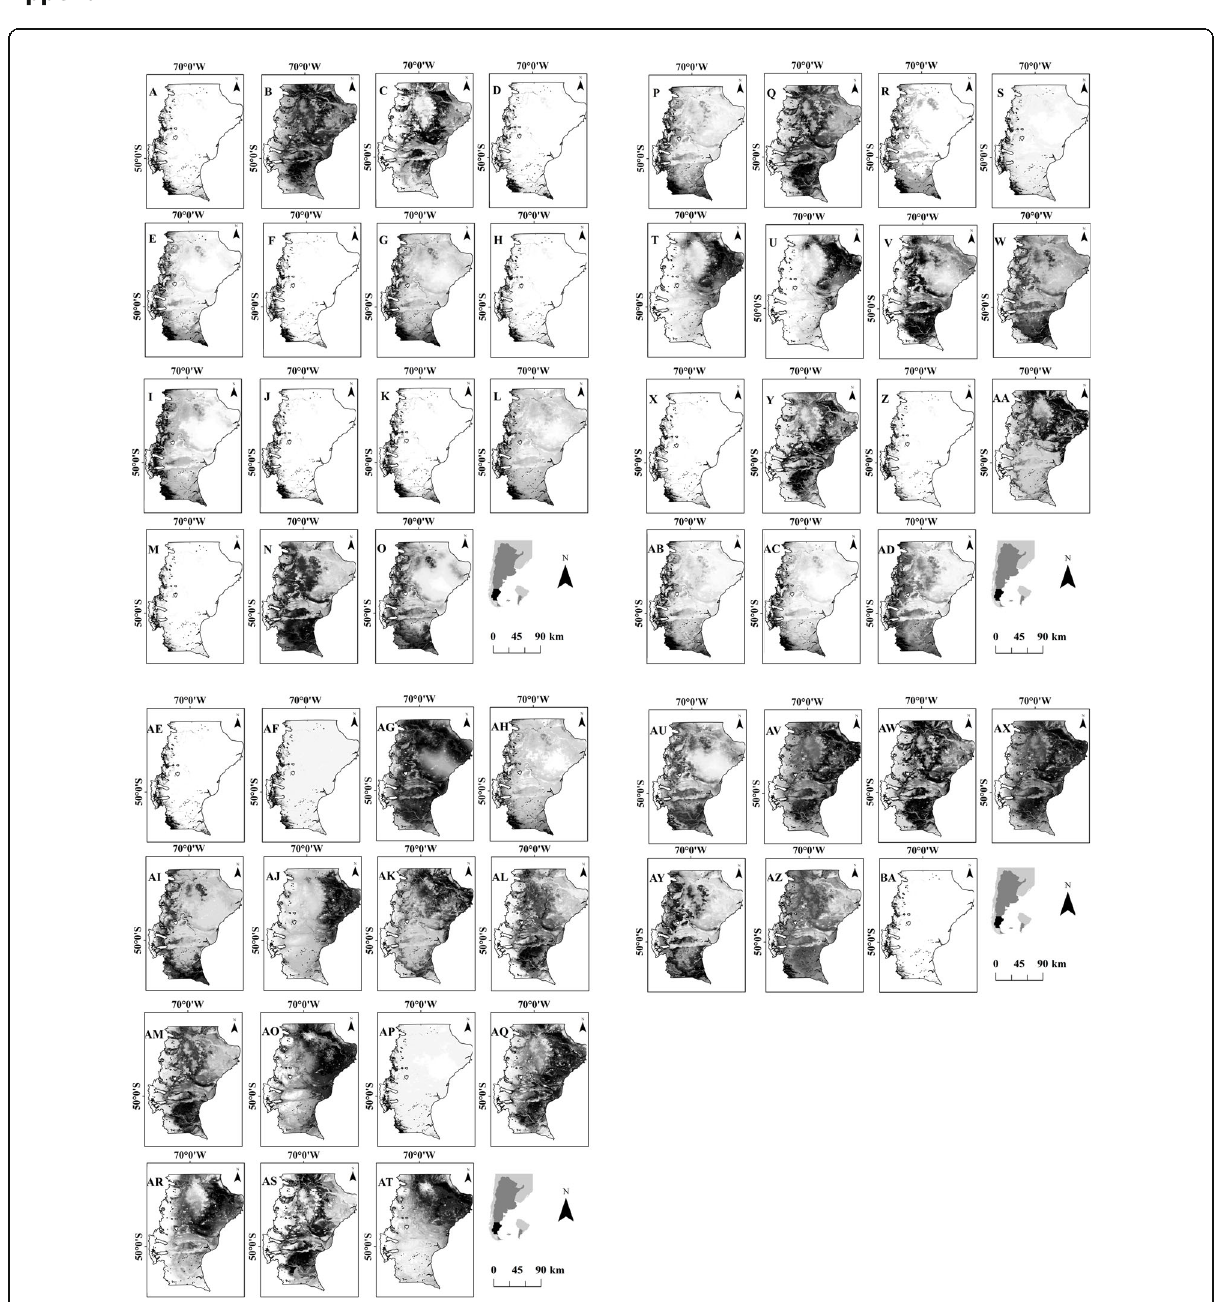
Fig. 7 Potential habitat suitability (PHS) maps of plants species in Santa Cruz province, where light grey showed the lowest potential and black showed the highest potential areas (0 – 100%). A, Acaena magellanica ; B, Acaena poeppigiana ; C, Adesmia volckmannii ; D, Agrostis capillaris ; E, Agrostis perennans ; F, Anemone multifida ; G, Armeria maritima ; H, Avenella flexuosa ; I, Azorella prolifera ; J, Baccharis magellanica ; K, Berberis empetrifolia ; L, Berberis microphylla ; M, Blechnum penna-marina ; N, Bromus setifolius ; O, Calceolaria uniflora ; P, Carex andina ; Q, Carex argentina ; R, Carex macloviana ; S, Chiliotrichum diffusum ; T, Chuquiraga aurea ; U, Chuquiraga avellanedae ; V, Clinopodium darwinii ; W, Colobanthus subulatus ; X, Empetrum rubrum ; Y, Ephedra chilensis ; Z, Escallonia rubra ; AA, Festuca argentina ; AB, Festuca gracillima ; AC, Festuca magellanica ; AD, Festuca pallescens ; AE, Galium aparine ; AF, Gaultheria mucronata ; AG, Hordeum comosum ; AH, Hordeum pubiflorum ; AI, Juncus balticus ; AJ, Lycium chilense ; AK, Microsteris gracilis ; AL, Mulguraea tridens ; AM, Nardophyllum bryoides ; AN, Nassauvia glomerulosa ; AO, Nassauvia ulicina ; AP, Osmorhiza chilensis ; AQ, Pappostipa chrysophylla ; AR, Pappostipa chubutensis ; AS, Pappostipa ibarii ; AT, Pappostipa sorianoi ; AU, Perezia recurvata ; AV, Poa lanuginosa ; AW, Poa ligularis ; AX, Poa spiciformis ; AY, Rytidosperma virescens ; AZ, Senecio filaginoides ; BA, Viola